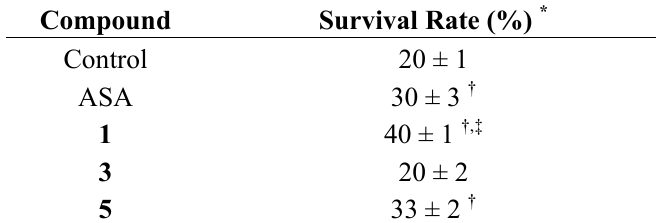
Table 3. Antithrombotic effects of ASA and compounds 1 , 3 , and 5 on pulmonary thromboembolism induced by a mixture of collagen and epinephrine in mice in vivo. Compound Survival Rate (%)